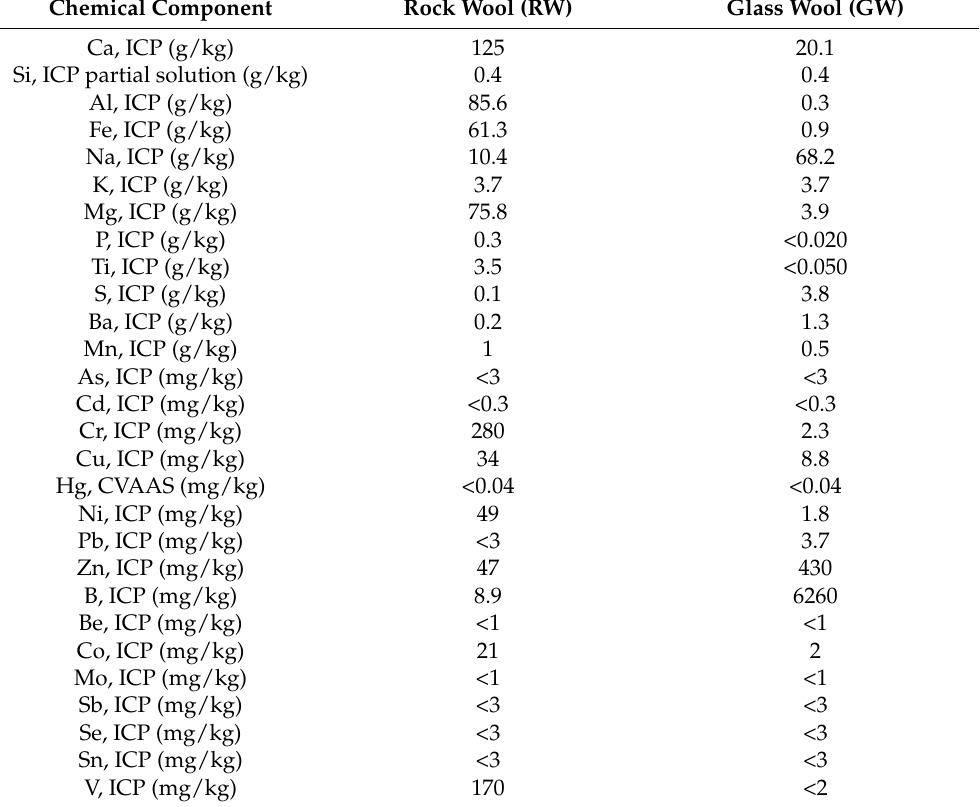
Table 11. The chemical composition of rock wool (RW) and glass wool (GW), determined by ICP- OES